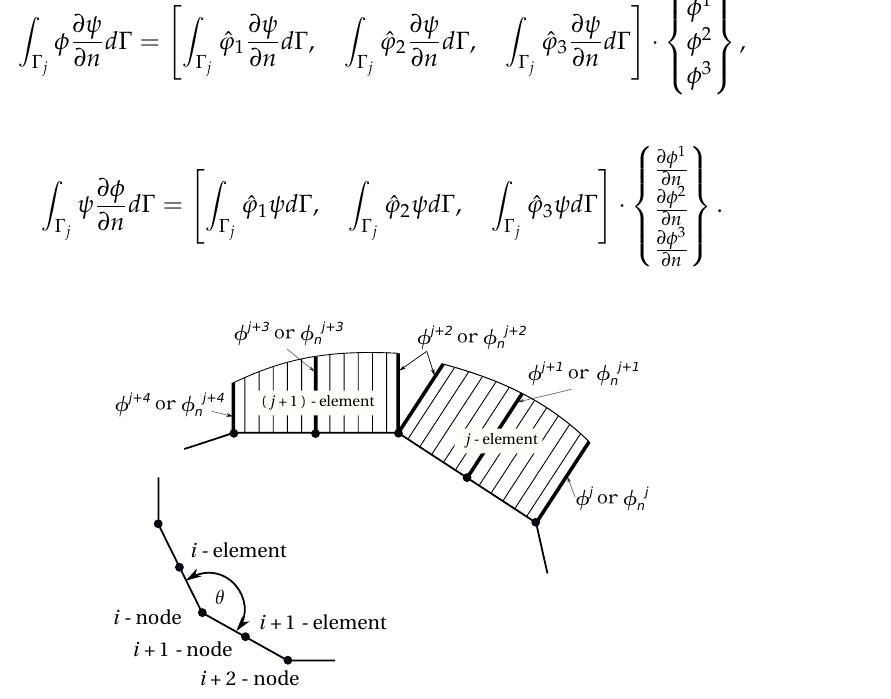
Figure 4. Schematic diagram of the modeling of the boundary with quadratic